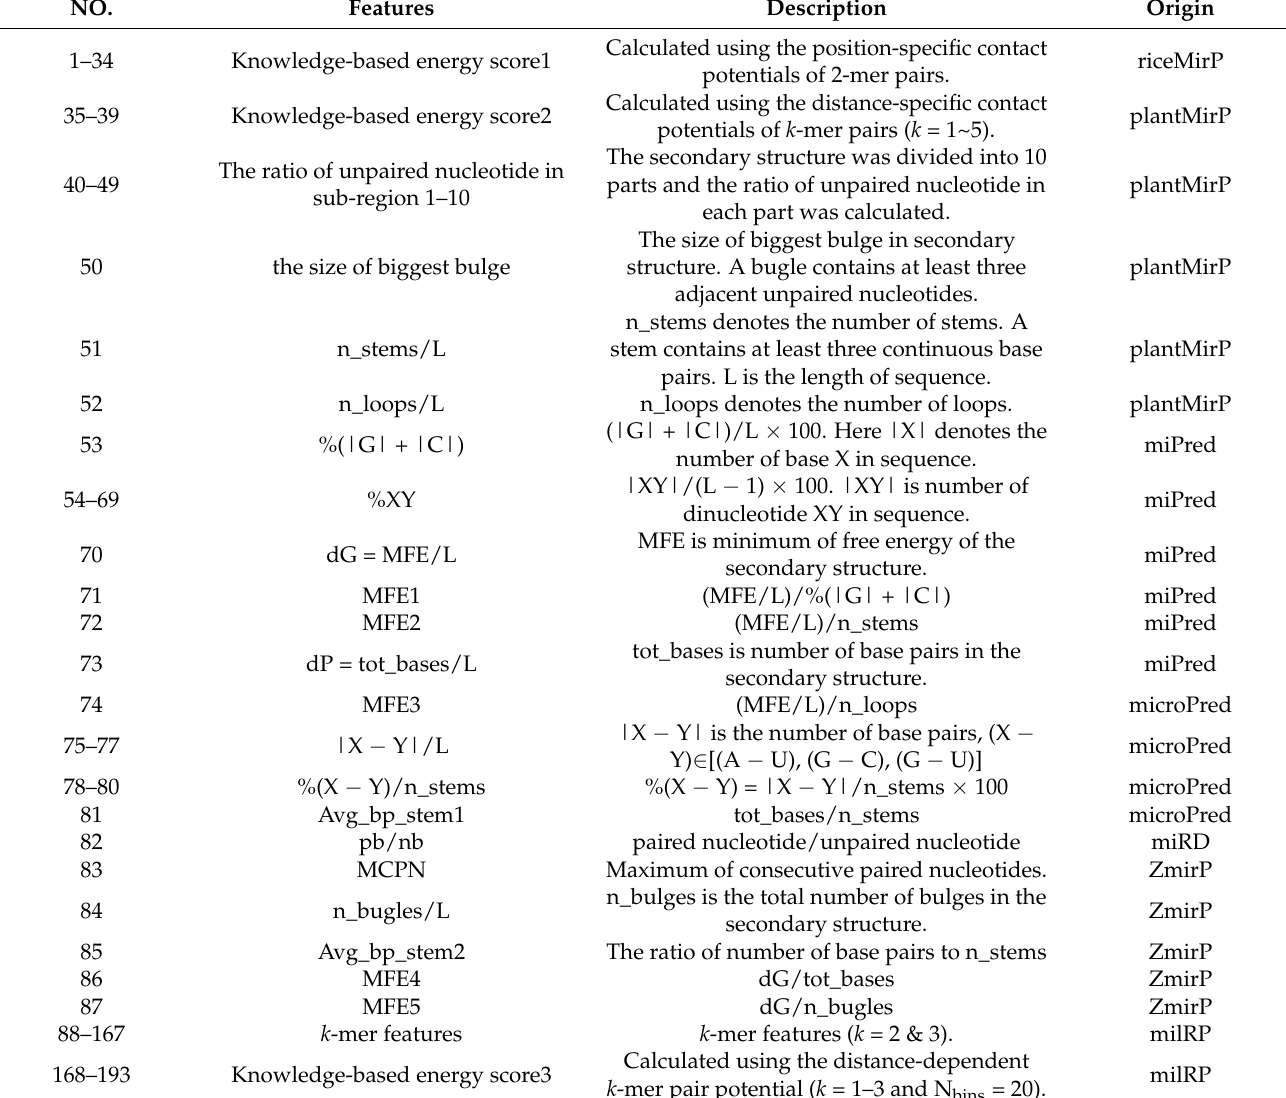
Table 2. Full features used in